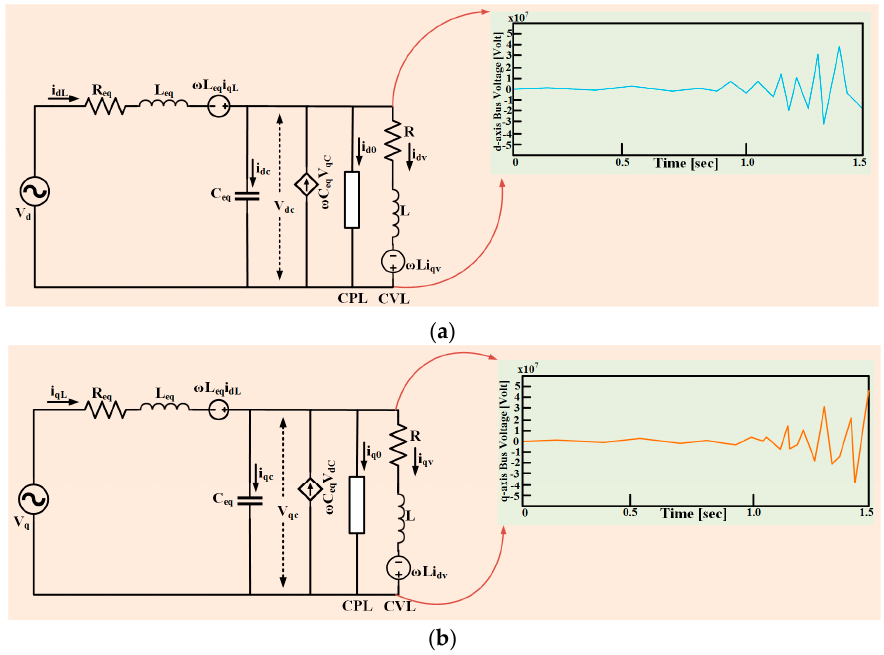
Figure 6. The schematic diagram of a microgrid system, which has been made unstable by a CPL while control inputs are absent. Equivalent circuits and bus voltages of the microgrid are shown for d-axis in ( a ), and for q-axis in ( b ); the measurement locations are also